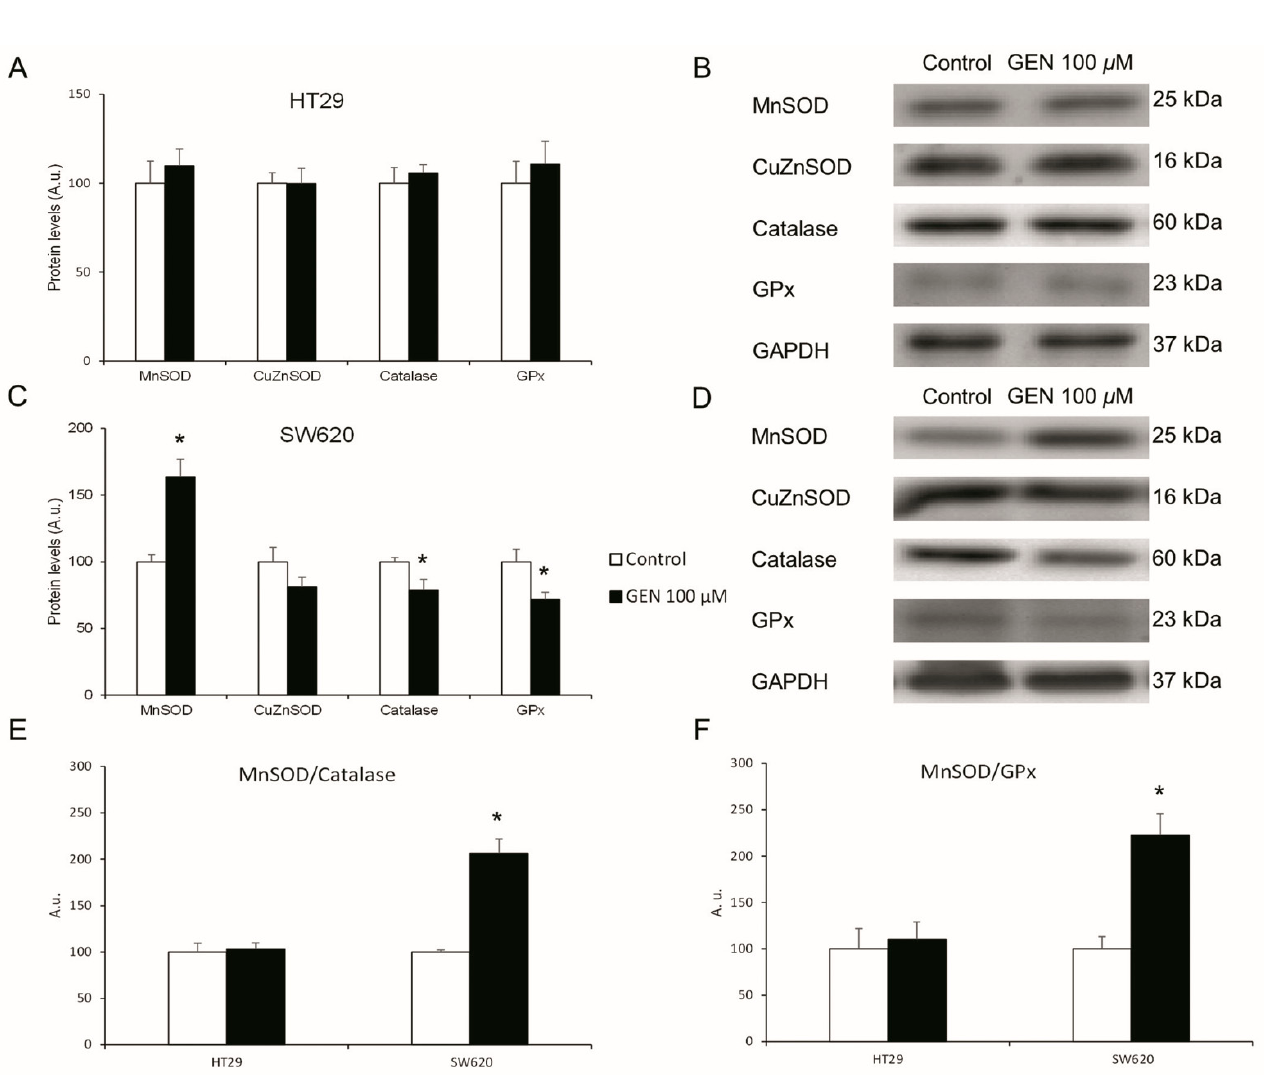
Figure 5. Effects of genistein on protein expression levels. Antioxidant enzymes (MnSOD, CuZnSOD, Catalase, GPx) in ( A ) HT29 cells and ( C ) SW620 cells determined by Western blot. Western blot representative bands in ( B ) HT29 cells and ( D ) SW620 cells. Effects of genistein on protein expression level ratios of ( E ) MnSOD/Catalase and ( F ) MnSOD/GPx determined by Western blot. The measurements were made with genistein 100 µ M or 0.1% DMSO (control cells) treatment for 48 h. Values are expressed as mean ± SEM and control values (DMSO-treated cells) were set at 100. GEN, genistein; A.u., arbitrary units. * Significant difference between control cells and genistein-treated cells (Student’s t -test; p < 0.05, n =